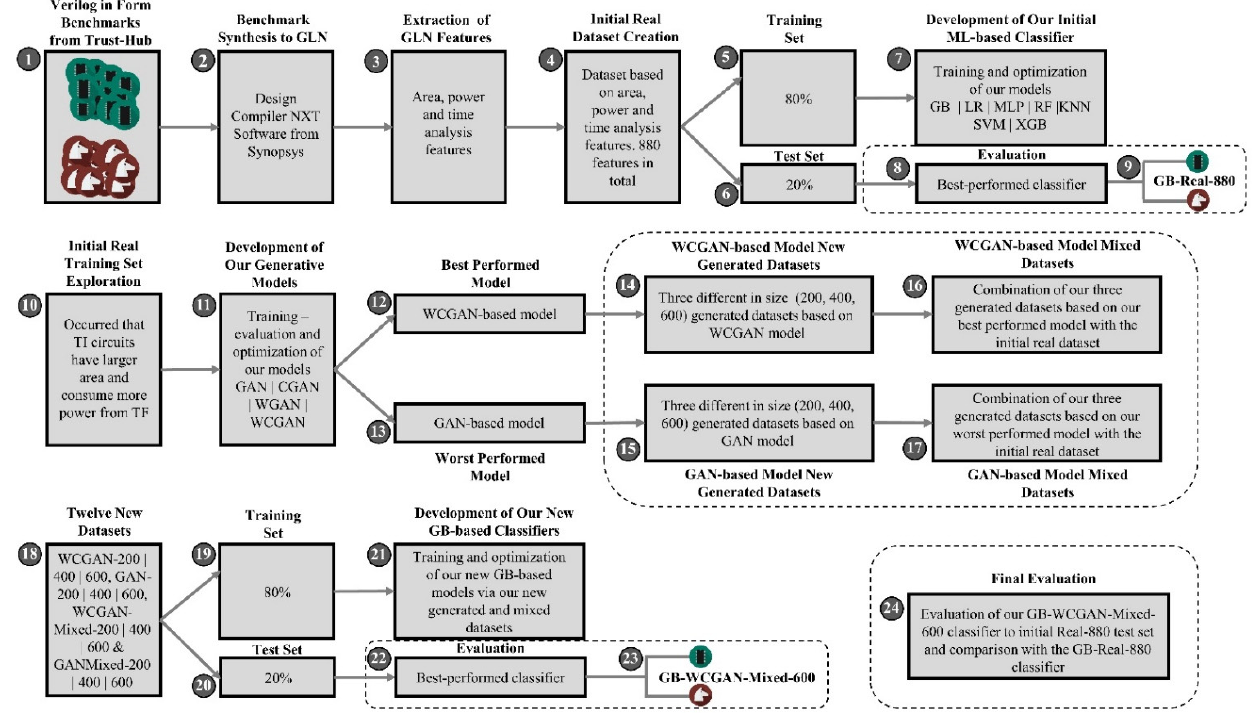
Figure 3. Scheme of our Artificial Intelligence-based approach for safeguarding integrated circuits at gate-level netlist phase against hardware Trojans, GAINESIS.